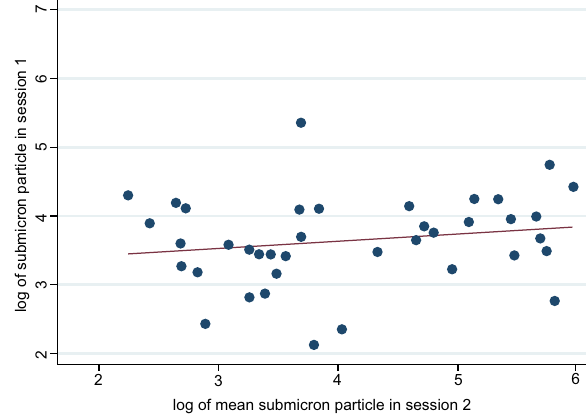
Figure 2. 5-day moving average of daily average pollen counts during the 2009 pollen season.